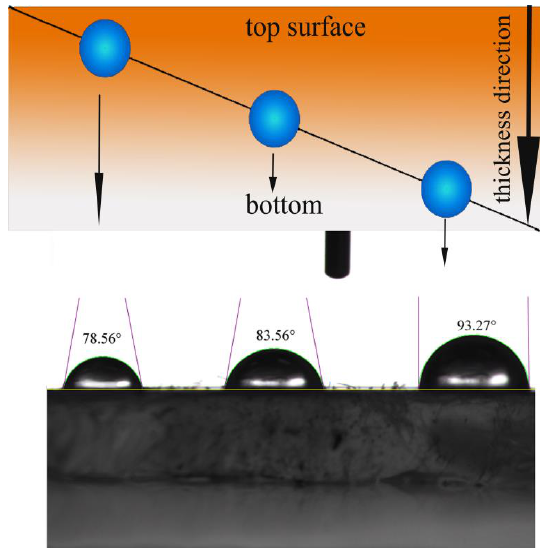
Figure 4. Water contact angles on the fracture surface of the gradient IPN. Regions are symmetrically selected along the diagonal line of the fracture surface and they are from 1/4 h, 2/4 h and 3/4 h, respectively. Here “h” represents the thickness of the IPN